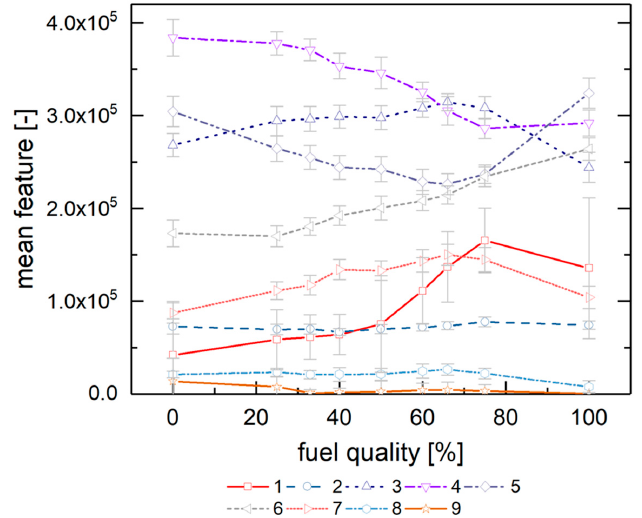
Figure 4. Extracted histogram-based features as mean values with respect to the fuel class; axis is not normalized for the purpose of better visibility only. Error bars indicate the standard deviation.